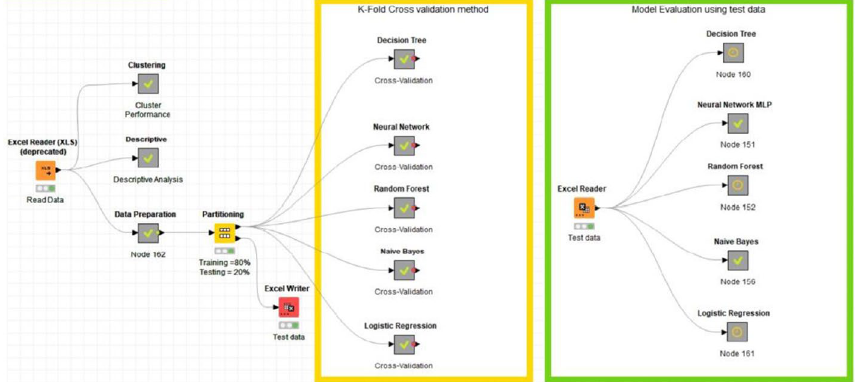
Fig. 3 The overall KNIME workflow for the prediction of production delay